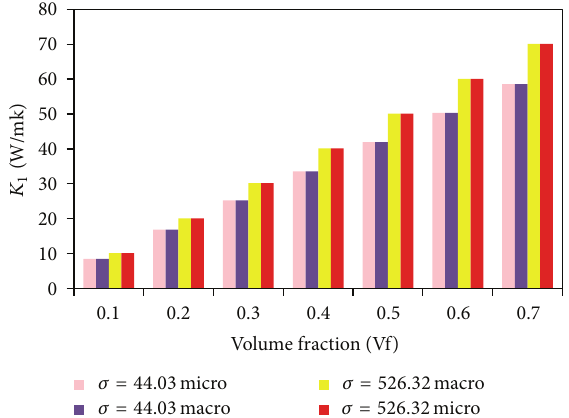
Figure 16: Variation in 𝐾 1 with respect to Vf for a composite with one in four fibres in unit cell fully debonded.